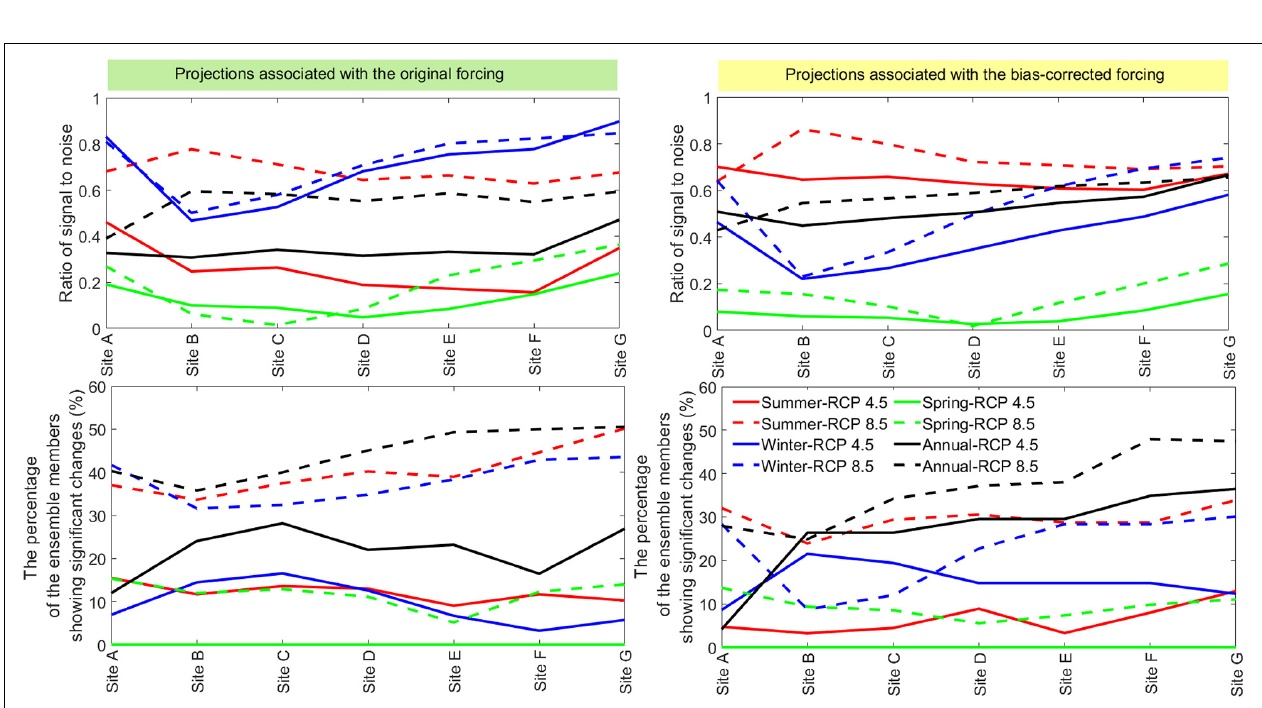
FIGURE 12 | Projected changes in northward seasonal mean LST rates, under RCP 8.5, obtained from using the original forcing conditions (left panel) and the bias-corrected ones (rigth panel) .